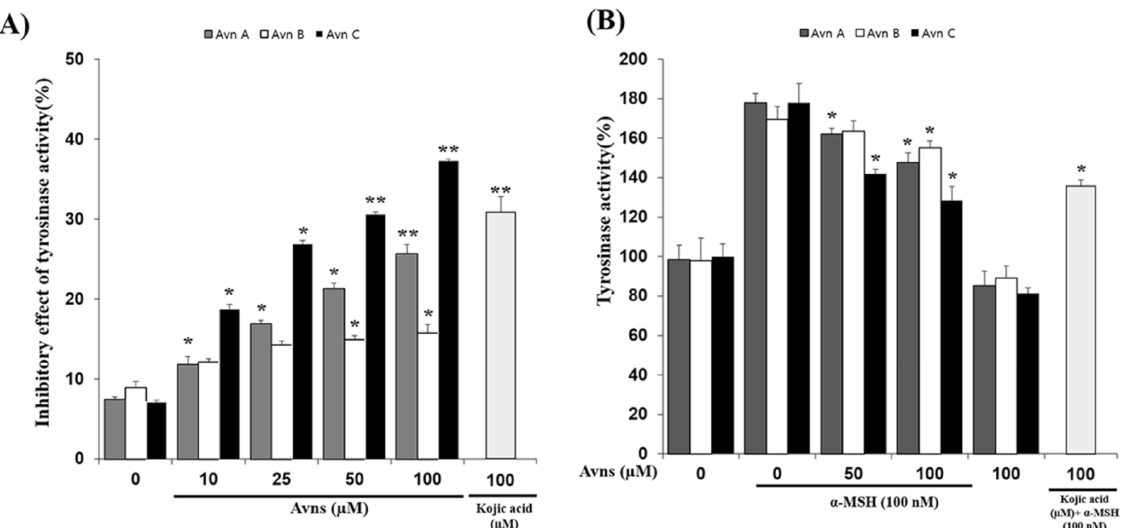
Figure 2. Inhibitory effect of Avenanthramides (A, B, C) on tyrosinase activity in vitro and in α -MSH-activated SK-MEL-2 cells. ( A ) in vitro treatment with AvnA, AvnB, and AvnC inhibited tyrosinase activity in a concentration-dependent manner. Cells were treated with compounds at 0, 10, 25, 50, and 100 µ M. Kojic acid (100 µ M) was used as a positive control. ( B ) α -MSH-induced SK-MEL-2 cells treated with AvnA, AvnB, and AvnC likewise demonstrate concentration-dependent (0, 50, 100 µ M) inhibition of tyrosinase activity. Kojic acid (100 µ M) was used as a positive control. The results shown are mean ± SEM and represent three independent tests. * p < 0.05 and ** p < 0.01 = significant differences from the α -MSH -treated cells.